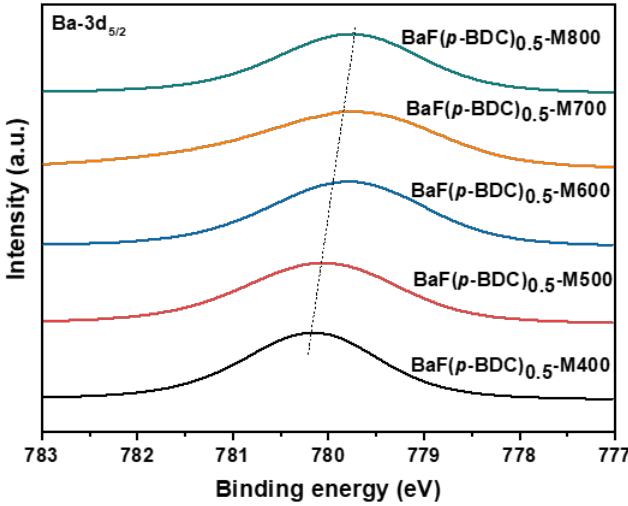
Figure 3. Ba 3d XPS spectra of calcinated BaF( p −BDC) 0.5 catalysts. Figure 4 exhibited the SEM images of the calcinated catalysts. For BaF( p −BDC) 0.5 −M500, irregular particles were obtained after calcination. The average size